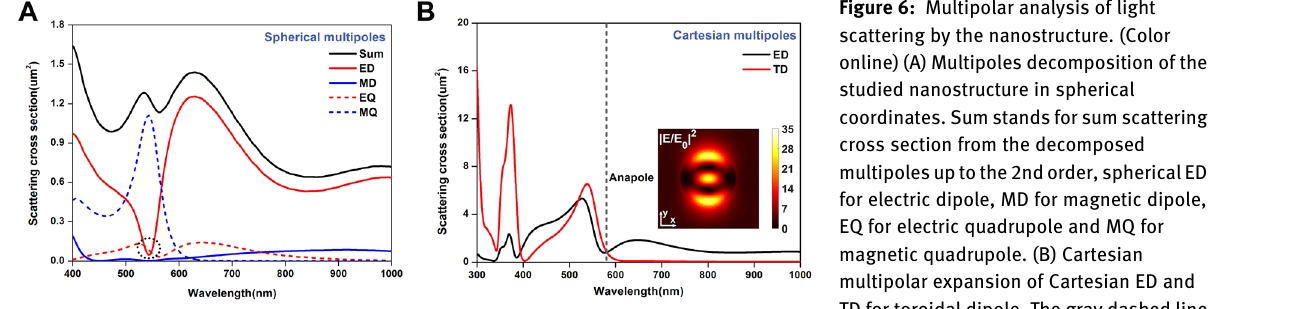
Figure 6: Multipolar analysis of light scattering by the nanostructure. (Color